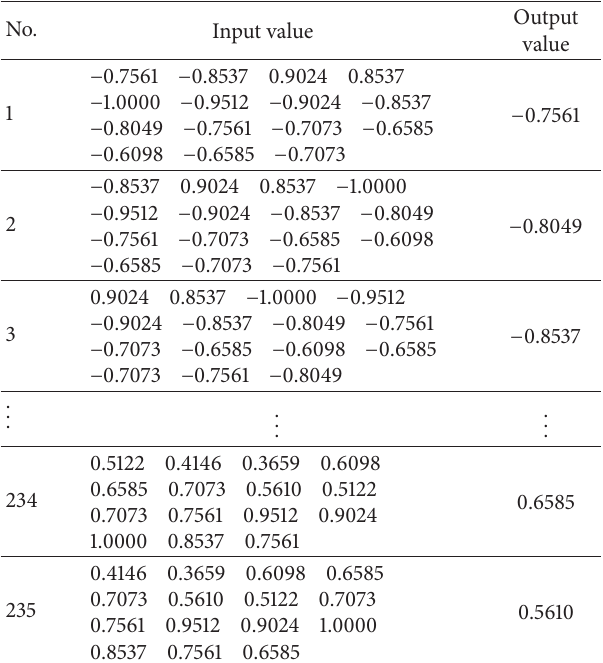
Table 2: Input and output